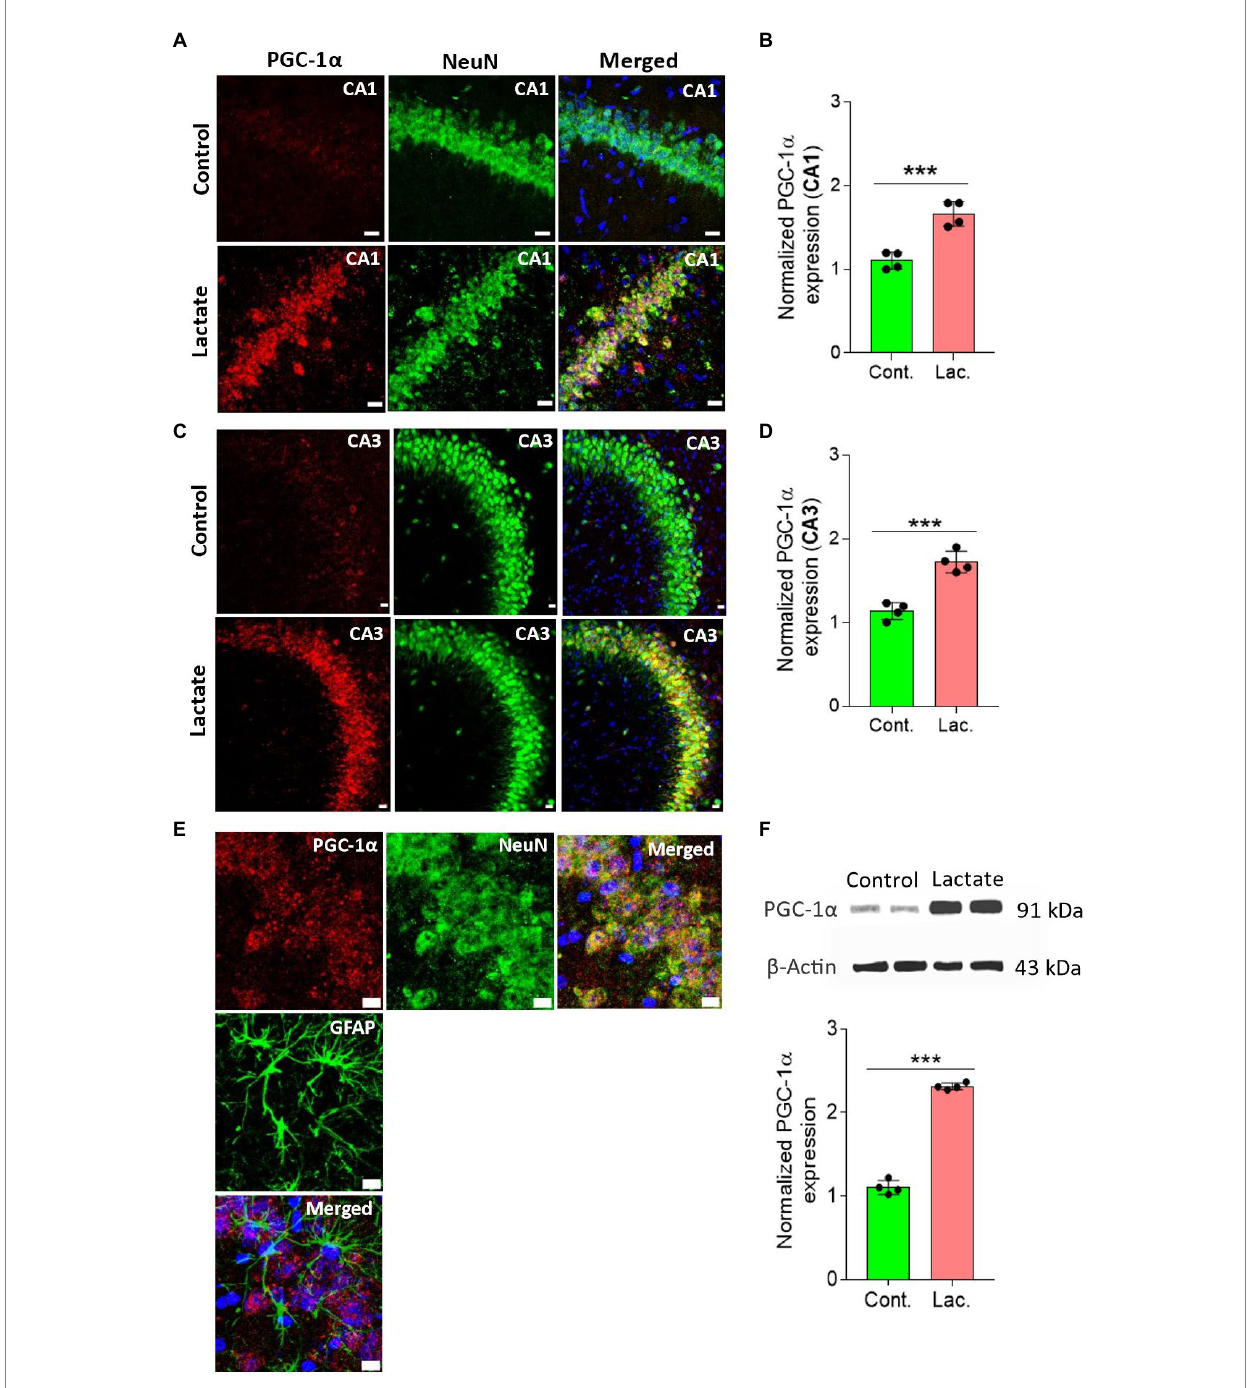
FIGURE 4 L-lactate increases PGC-1 α expression in neurons of HPC. (A,C) Representative confocal micrograph of PGC-1 α (red) co-labelled with NeuN (green) in the CA1 (A) and CA3 (C) areas of HPC of control and lactate groups. L-lactate infusion increased PGC-1 α expression in both areas of HPC. Scale bars: 20 μ m. (B,D) Fluorescence intensity of PGC-1 α stained sections in the CA1 (B) and CA3 (D) areas of HPC of lactate group was assessed and normalized to control group. Data are shown as mean ± SD (n = 4 rats per group). p *** < 0.001, unpaired Student’s t -test. (E) Representative confocal micrograph of PGC-1 α (red) co-labelled with GFAP (green) or NeuN (green) in the HPC of lactate group. Scale bars: 10 μ m. (F) Representative WB images of PGC-1 α in the HPC extracts from control and lactate groups. Intensity of PGC-1 α was quantified and normalized with β -actin. PGC-1 α was found to be significantly increased in lactate group compared to control. Data are shown as mean ± SD ( n = 4 rats per group). p *** < 0.001, unpaired Student’s t